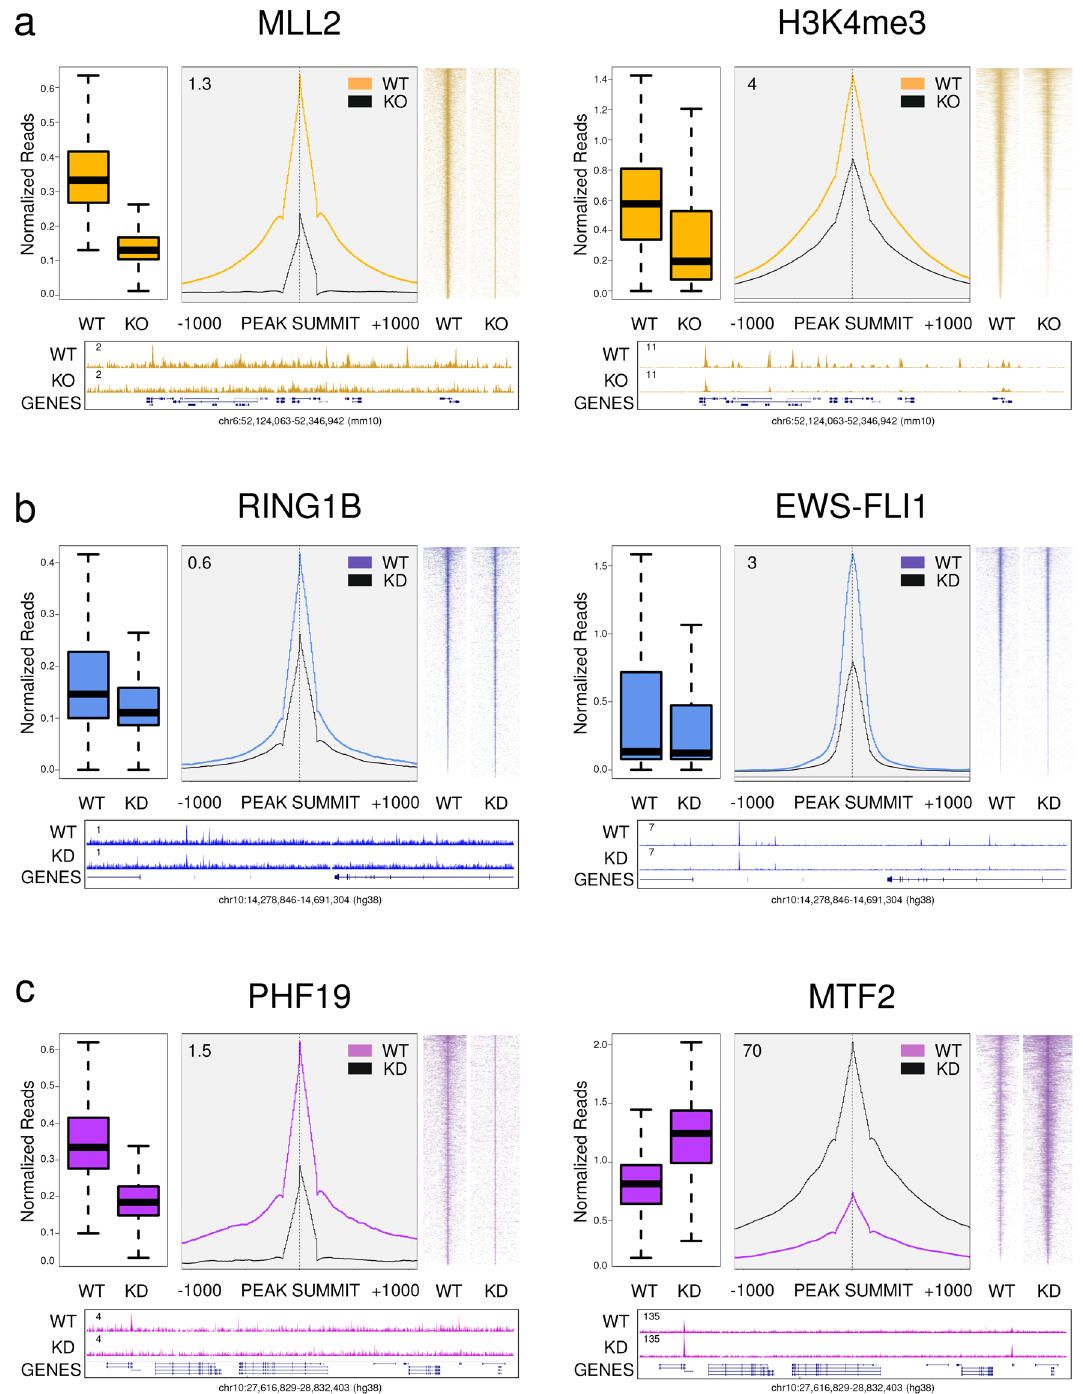
Figure 7. Evaluation of ChIP-seq experiments after genetic perturbation with SeqCode. (a) Study of the efficiency of MLL2 knockout (KO) in mESCs (left) and its effect over the occupancy pattern of H3K4me3 (right). (b) Study of the efficiency of RING1B knockdown (KD) in the Ewing sarcoma A673 cell line (left) and its effect over the binding pattern of EWS-FLI1 oncogenic protein (right). (c) Study of the efficiency of PHF19 KD in the prostatic cancer DU145 cell line (left) and its effect over the pattern of MTF2 (right). Peaks called in the wild- type (WT) condition of the factor being analyzed on each case were used as a reference in both conditions. For every pair of WT-KO/KD experiments, ChIP-seq normalized levels ( recoverChIPlevels ), and the average distribution ( producePEAKplots ) and heatmap ( producePEAKmaps ) around the peaks are shown. Below, genome-wide screenshots of the WT and KO/KD profiles on a locus containing peaks of this class were generated with the SeqCode buildChIPprofile function. Boxplots of ChIP-seq values are shown in log scale. All samples were normalized by the total number of reads of each experiment, except MTF2 ChIP-seq samples that were normalized by the total number of spike-in fruit-fly reads. Raw data were retrieved from 40–42